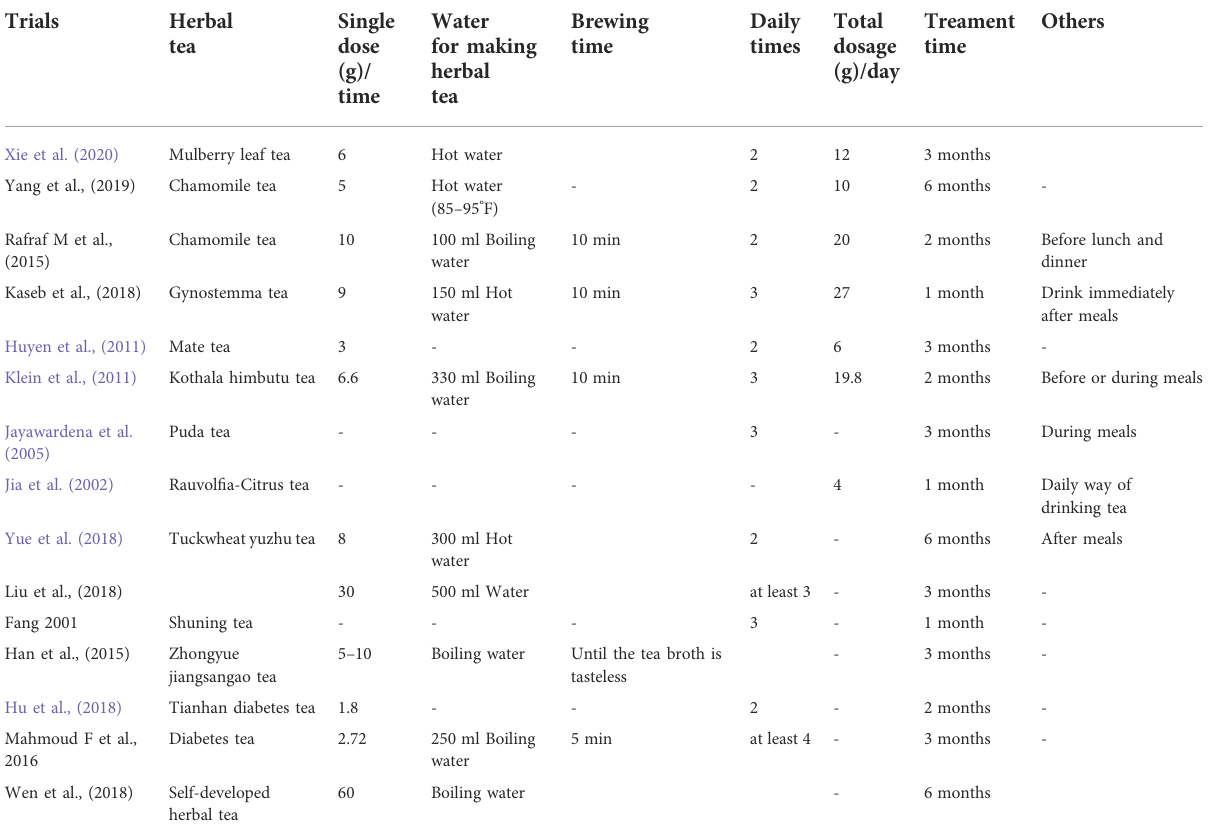
TABLE 3 Dosage and usage of